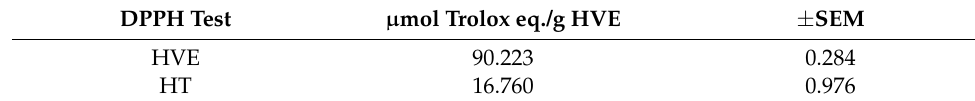
Table 3. Values of DPPH radical scavenging activities of HVE and HT.